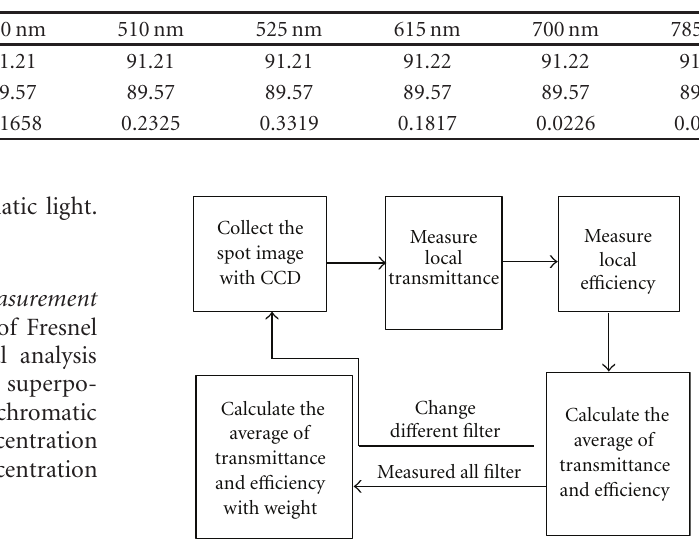
Table 2: The transmittance and concentration e ffi ciency of concentration system for di ff erent monochromatic light.